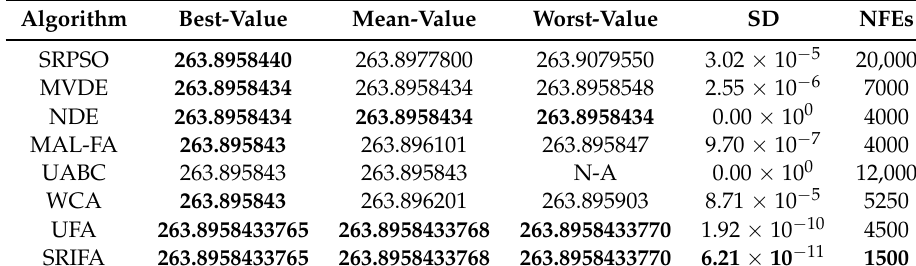
Table 14. Statistical results of comparison between SRIFA and NIAs for the three-bar truss problem.